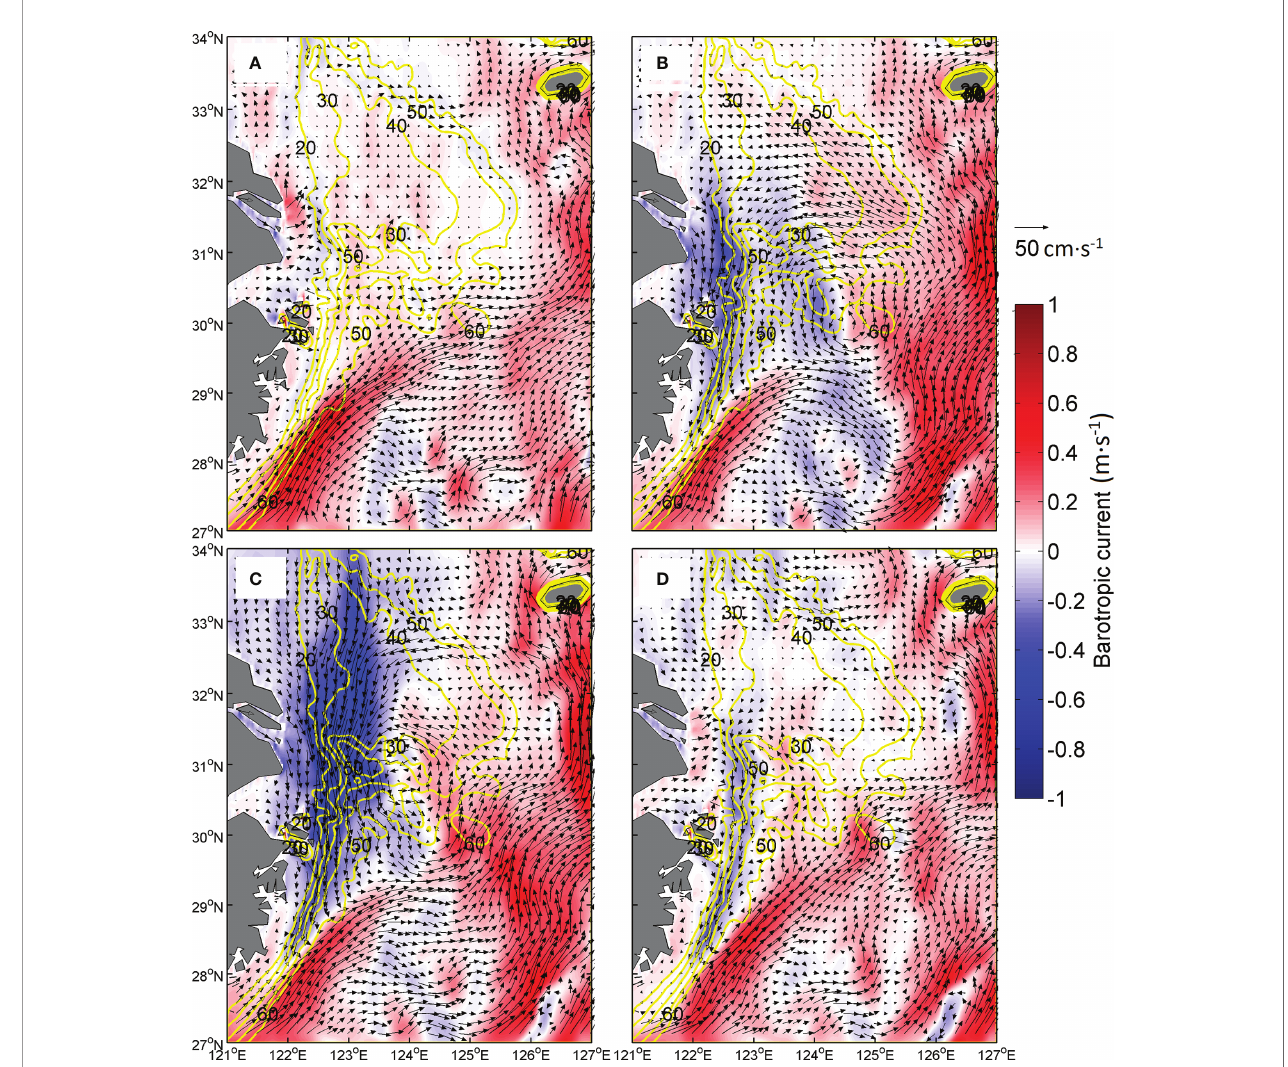
FIGURE 7 | Vectors for daily mean barotropic currents superimposed by colors for meridional velocity on August (A) 22, (B) 25, (C) 26, and (D) 28, 2020. Yellow lines indicate